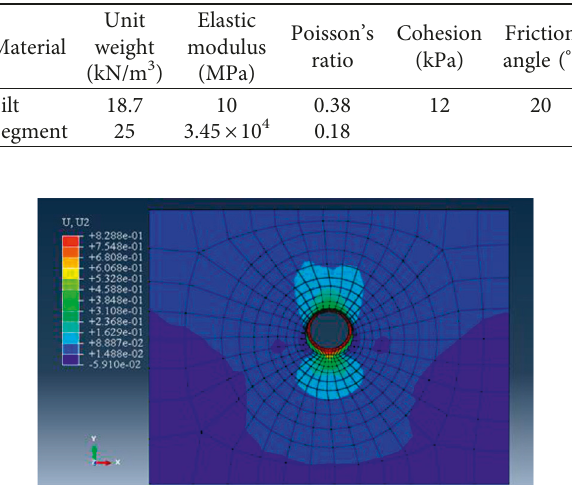
Figure 6: Vertical displacement of eight-layer